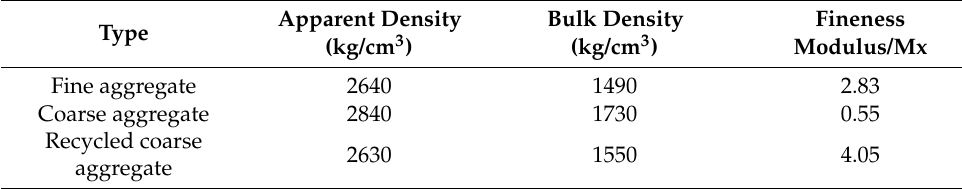
Table 5. Physical properties of aggregate.